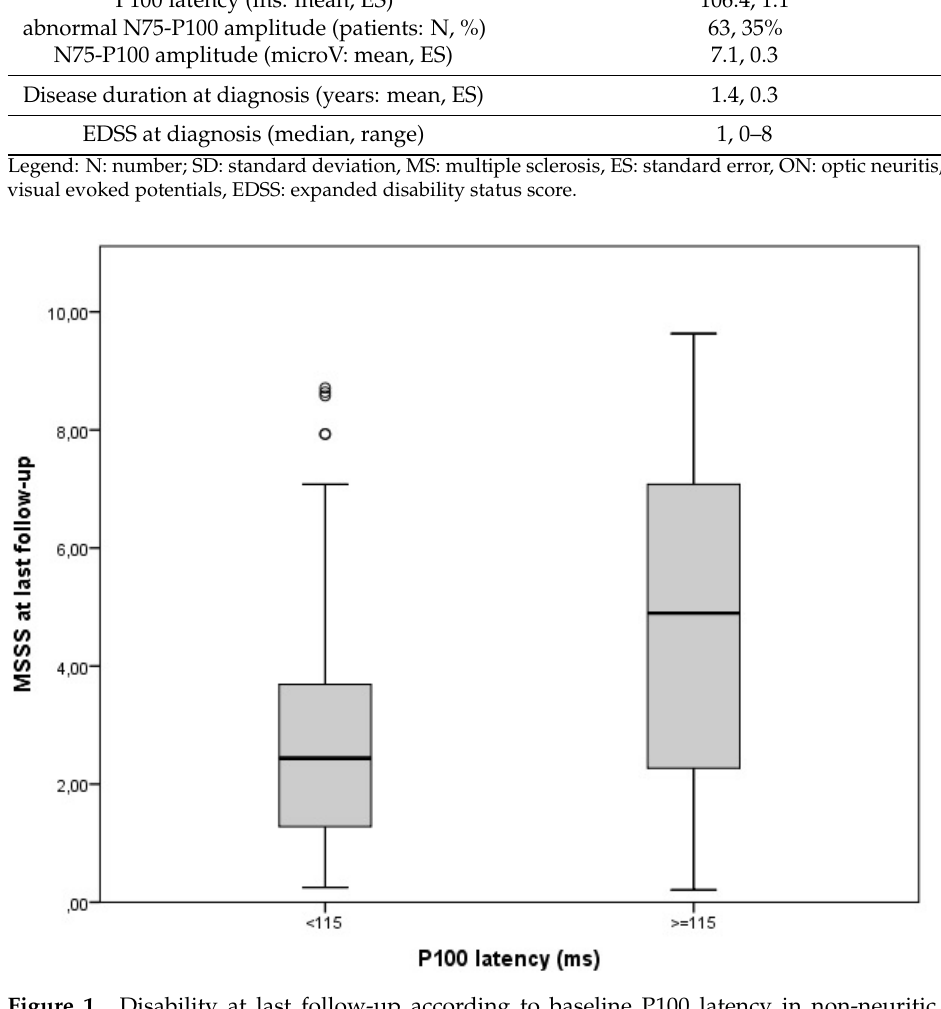
Figure 1. Disability at last follow-up according to baseline P100 latency in non-neuritic eyes ( p = 0.004).